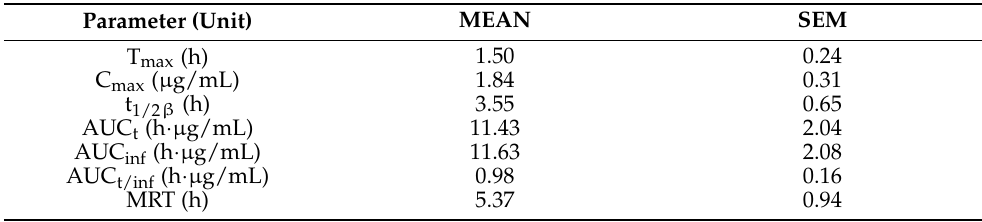
Table 1. Pharmacokinetic parameters of meloxicam in seven undulate skates ( Raja undulata ) (n = 7) after a single intramuscular administration (1.5